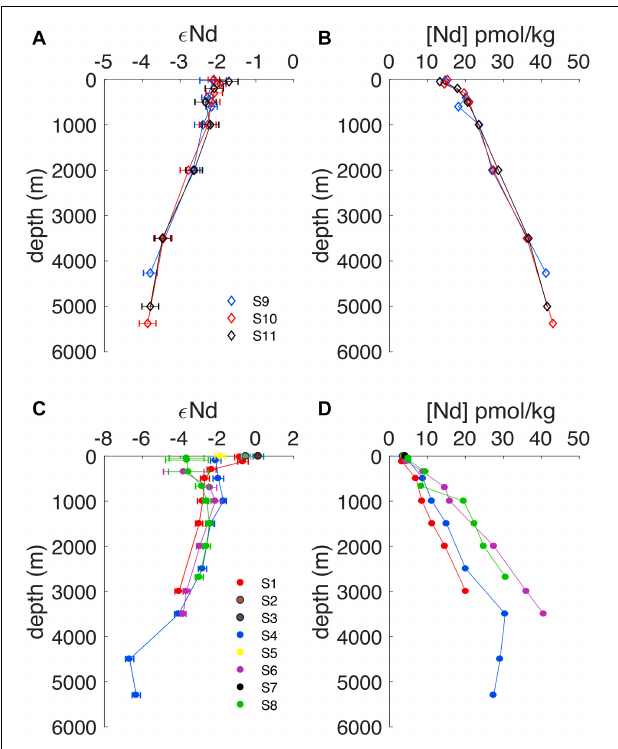
FIGURE 3 | ε Nd (A,C) and [Nd] (B,D) profiles for all stations. Upper graphs (A,B) display the stations north of 40 ◦ N, whereas bottom graphs (B,C) show stations south of 40 ◦ N. The error bars for ε Nd are reported as